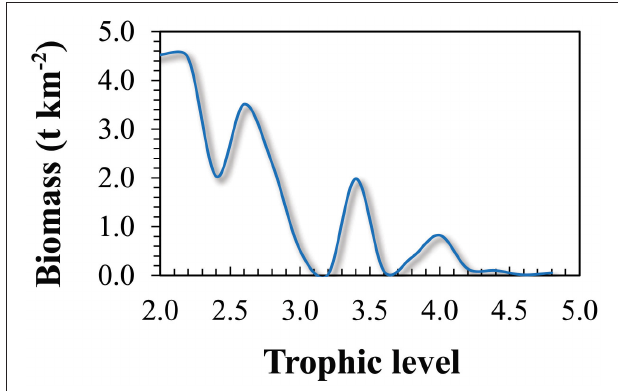
FIGURE 4 | Trophic spectra of the Azores ecosystem model for the reference year 1997.